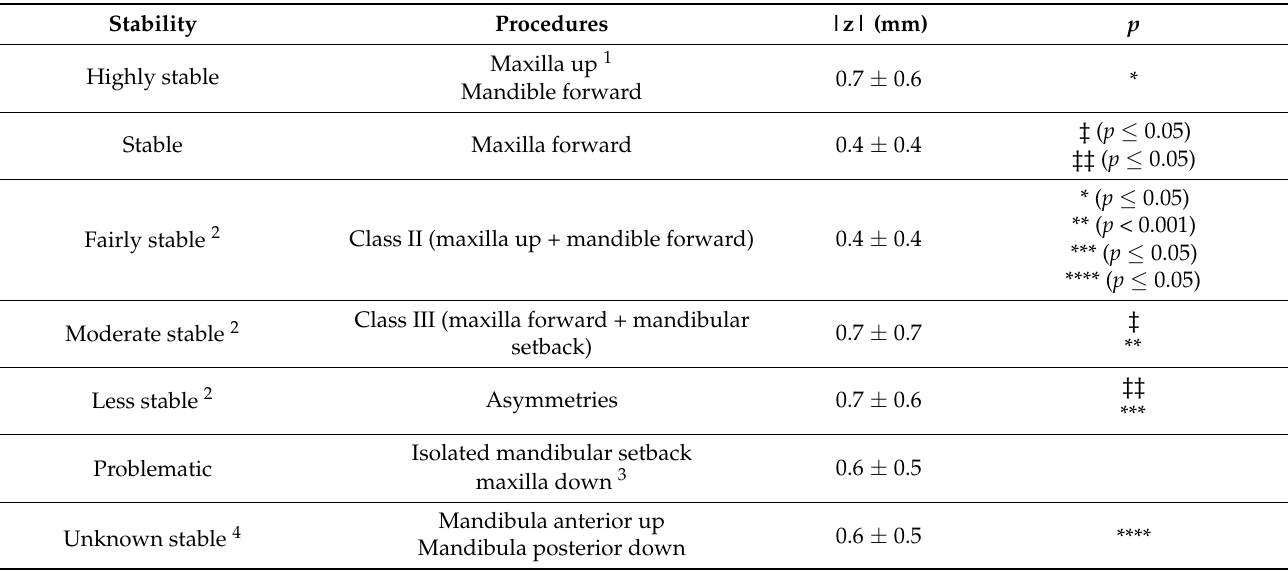
Table 3. Surgical procedures categorized according to Proffit’s hierarchy of postoperative stability in orthognathic surgery. Absolute mean ± sd differences and p-values for significant differences in anteroposterior (z-)